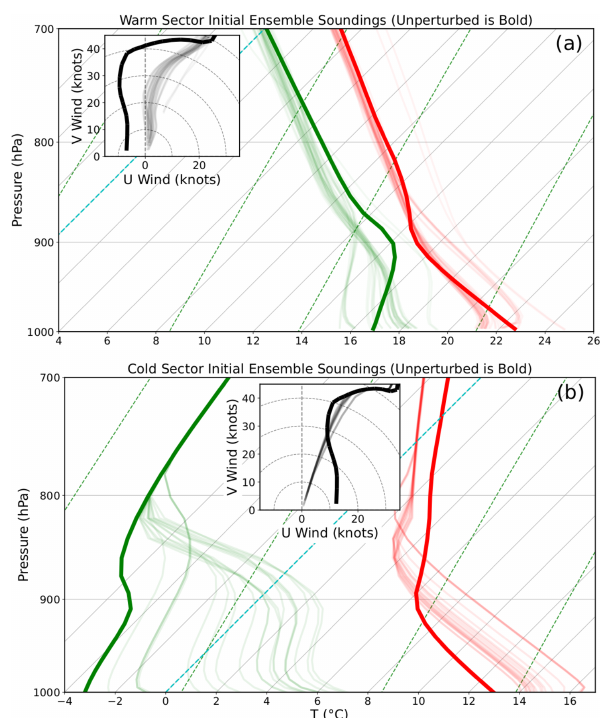
Figure 7. Profiles of the domain average (a) warm-sector and (b) cold-sector environments used to generate the initial ensemble. Red, green, and black lines correspond with T ( ◦ C), T d ( ◦ C), and wind (knots). The 40 ensemble member profiles are marked with a thin translucent line. The profiles used to initialize warm-sector and cold-sector simulations (i.e., the unperturbed soundings) are marked by a bold